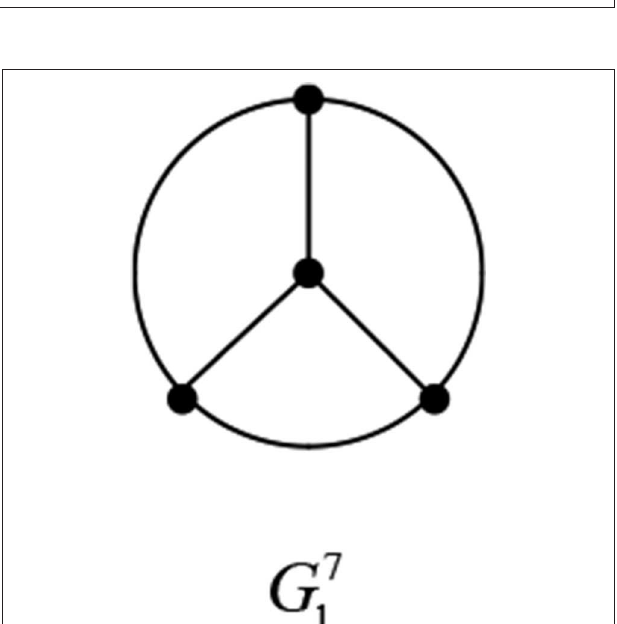
FIGURE 2 | The graphs G 4 i ( i